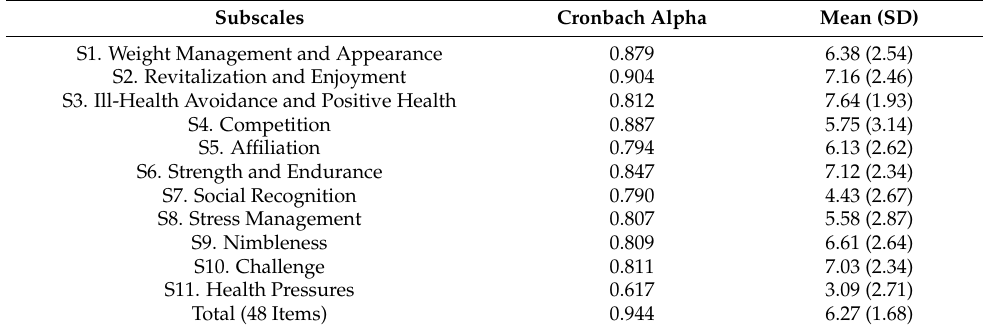
Table 2. Internal consistency and total score of AMPEF and its 11 subscales (N = 917).